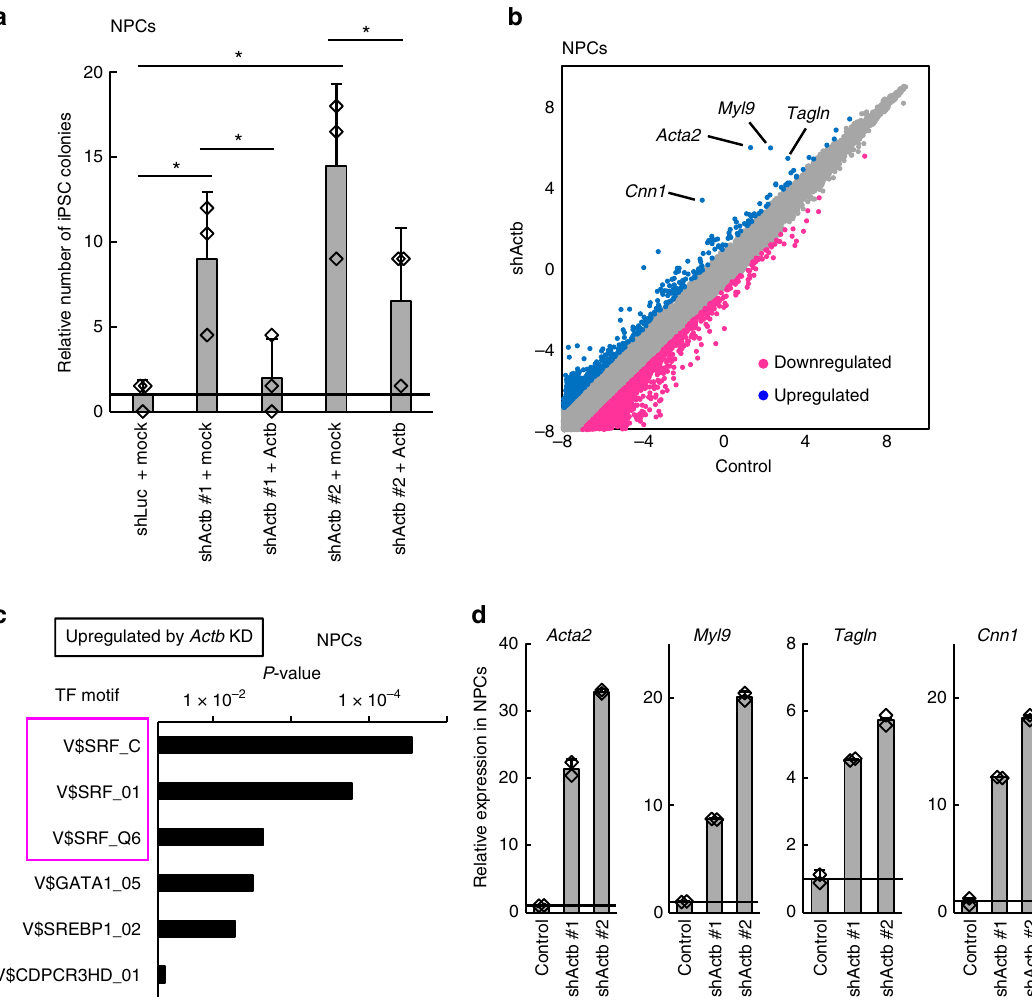
Fig. 2 β -Actin inhibits reprogramming and Srf activity. a Knockdown of Actb gene expression enhances reprogramming. Reprogramming ef fi ciencies from NPCs are shown as iPSC colony numbers relative to shLuc + mock-introduced cells. Means ± SD are shown ( n = 3). Dots indicate individual data points. Student ’ s t -test (* P < 0.05). b Knockdown of Actb alters various gene expressions. A scatter plot comparing gene expressions of Actb -knockdown NPCs and control cells. Blue dots and magenta dots show genes upregulated and downregulated > 2-fold, respectively. Some known Srf target gene symbols are indicated. c Srf-binding consensus motifs are enriched upstream of genes upregulated by Actb knockdown. Genes upregulated > 2-fold in NPCs were subjected to a motif search using Transfac to search protein-binding consensus sequences that were enriched in upstream regions. d Srf is activated by Actb knockdown. Expression levels relative to control cells for each Srf target gene in NPCs are shown ( n = 2, technical duplicate). Values are means± SD of the microarray data. Dots indicate individual data points